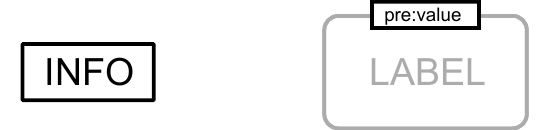
Figure 2.2: The Process Description glyph for unit of information , shown plain on the left, and decorating a macromolecule (Section 2.4.3) on the